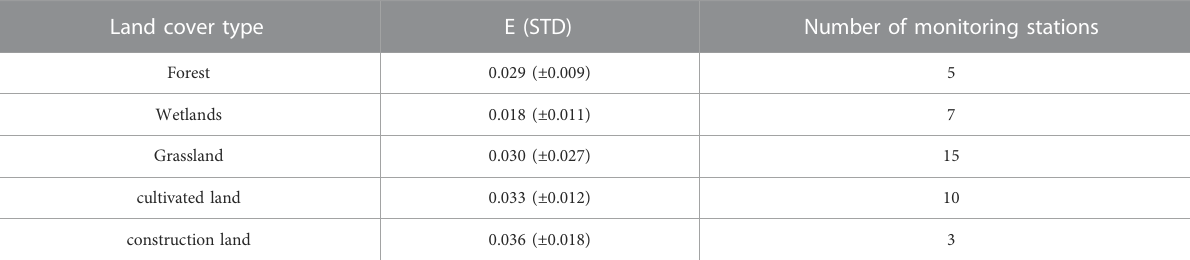
TABLE 1 E value of different land cover